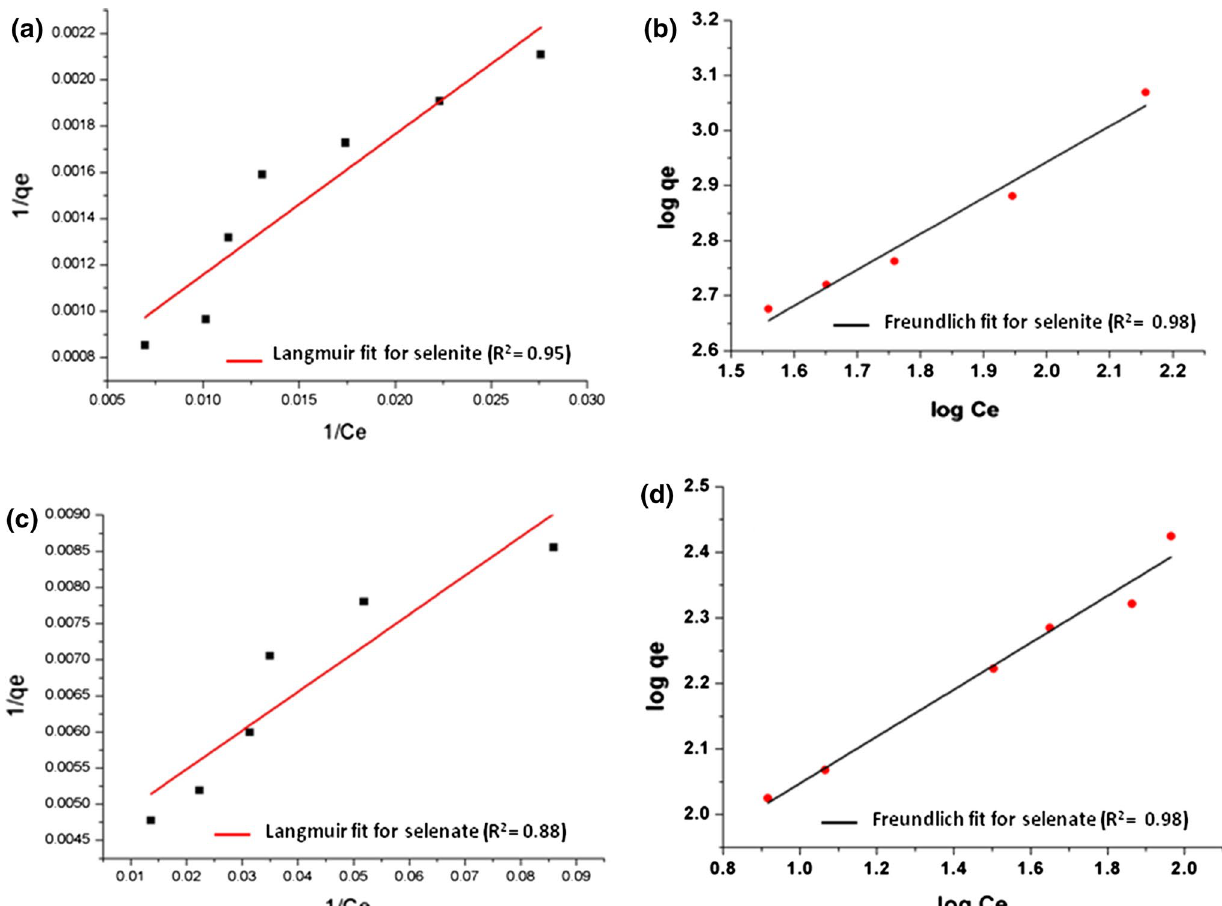
Fig. 3 Adsorption isotherms (batch volume 100 ml, temperature 30 ± 2 °C, initial Se concentration 200 µg L −1 , contact time 12 h). a Langmuir isotherm for selenite adsorption. b Freundlich isotherm for